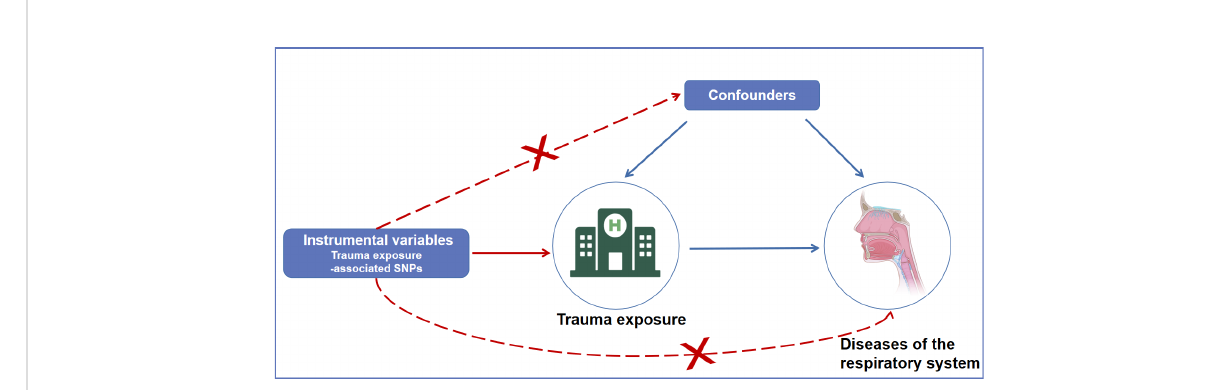
FIGURE 1 An overview of the MR assumptions. SNPs, single nucleotide polymorphisms; MR, Mendelian